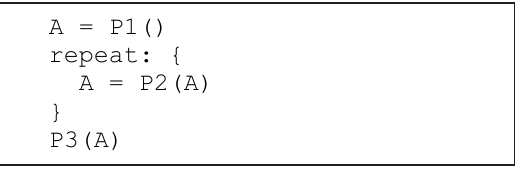
Fig. 13. An example of workflow